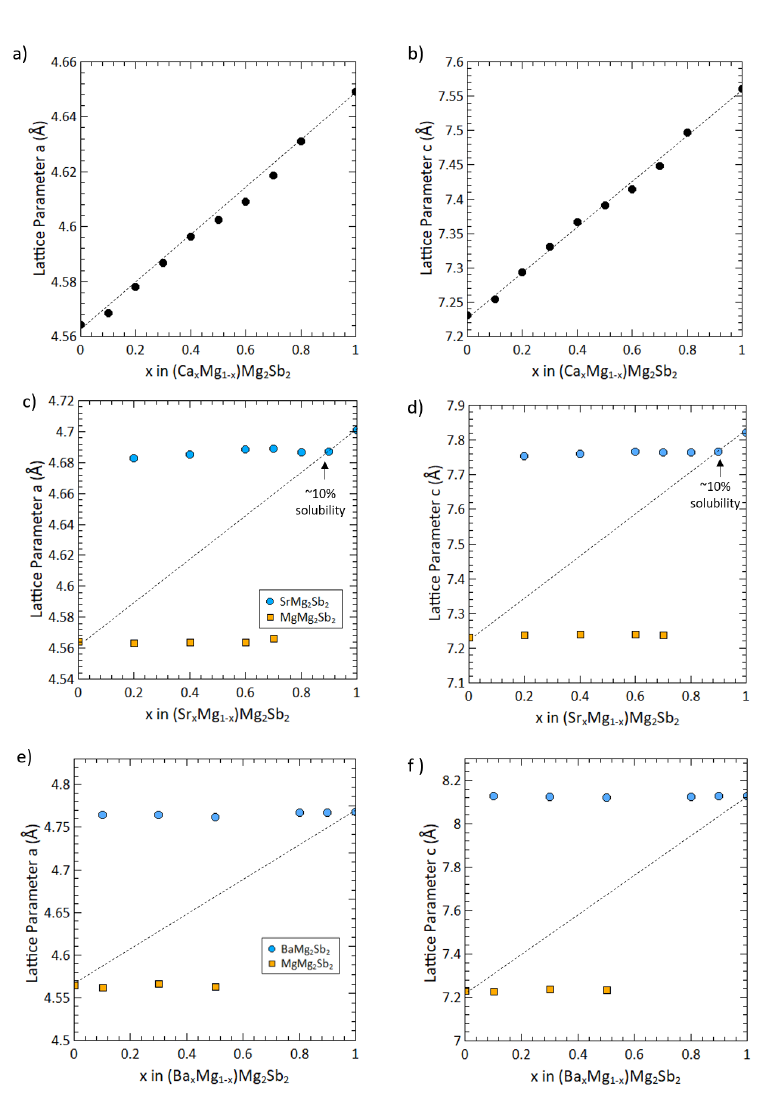
Figure 2. ( a , b ) For the (Ca x Mg 1 − x )Mg 2 Sb 2 series, the lattice parameters a and c underwent a linear change with calcium alloying ratio. ( c , d ) For the (Sr x Mg 1 − x )Mg 2 Sb 2 series, the lattice parameters indicate a 10% solubility for Sr on Mg site, and no solubility for Mg on Sr site. ( e , f )